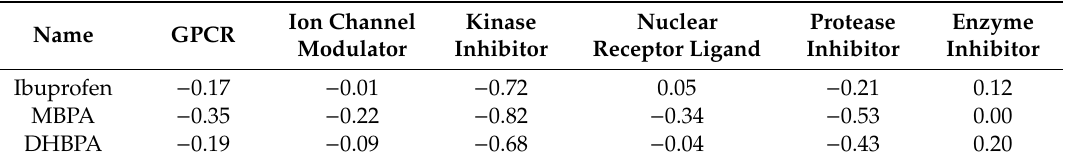
Table 4. Bioactivity of the ibuprofen and benzoylpropionic acid derivatives a